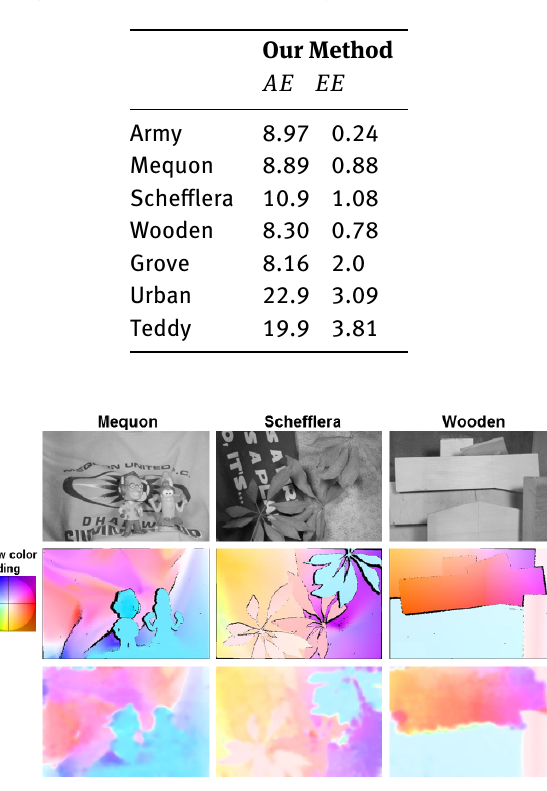
Table 1: Error statistics for motion perception estimation for a vari- ety of synthetic and real-world image sequences (Dataset 1).